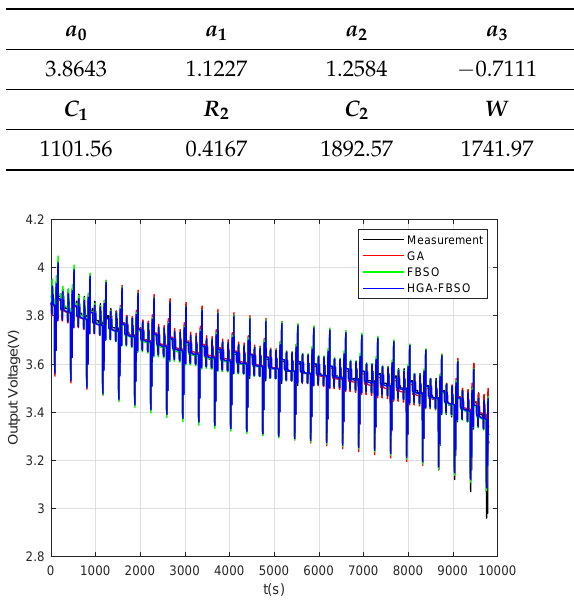
Table 3. The results of PI with the HGA-FBSO.